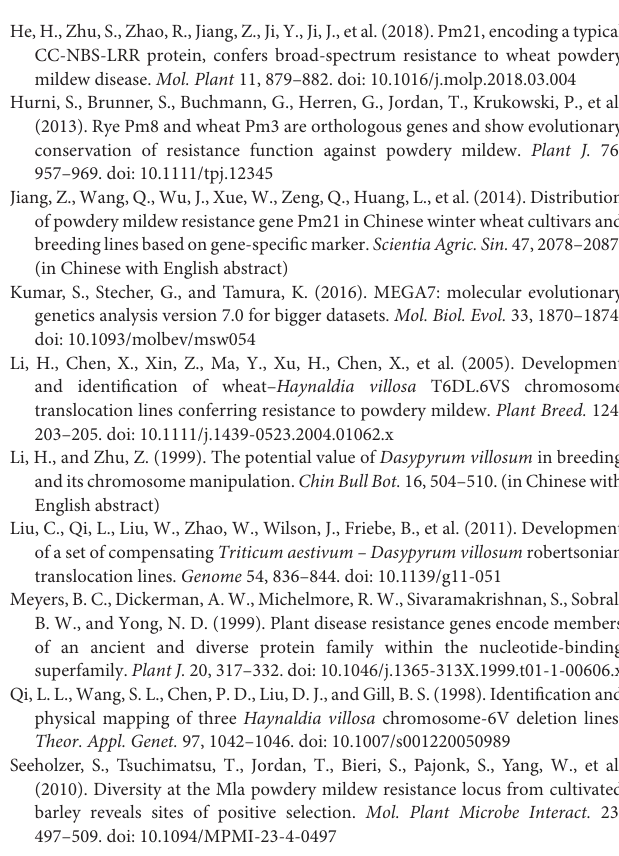
Figure S1 | Molecular analysis of the diversity of D. villosum by the marker MBH1 that was developed from the promoter region of Pm21 . M, DNA marker DL2000. Line 1 to 24, PCR products obtained from resistant individuals of different D. villosum accessions. Figure S2 | Multiple sequence alignment of different representative products PCR-amplified with the marker MBH1 . Figure S3 | Detection of mutations in the non-functional Pm21 alleles. (A) Mutations of Pm21-NF1 in DvSus-1 contrasted to Pm21 . (B) Mutations of Pm21-NF2 in DvSus-2, DvSus-3, and DA6V#3 contrasted to Pm21-C4 in DvRes-2 (derived from GRA961). (C) Mutations of Pm21-NF3 in DvSus-4 and DA6V#1 in contrast to Pm21-G2 in DvRes-3 (derived from GRA1114). SNPs, tandem premature stop codons and insertion sequences are shown by arrows, underlines and brackets, respectively. Figure S4 | Multiple sequence alignment of the surrounding sequences of kinase-2 motif (consensus sequence: LLVLDDVW) of plant disease resistance proteins. The conserved second aspartate (D) of kinase-2 motif is marked by an arrow. Table S1 | Pm21 alleles and the corresponding germplasms. Table S2 | InDel polymorphisms in the Pm21 alleles. All InDels, compared with Pm21 , occur after the positions showed in the brackets. Table S3 | Amino acid sites under positive